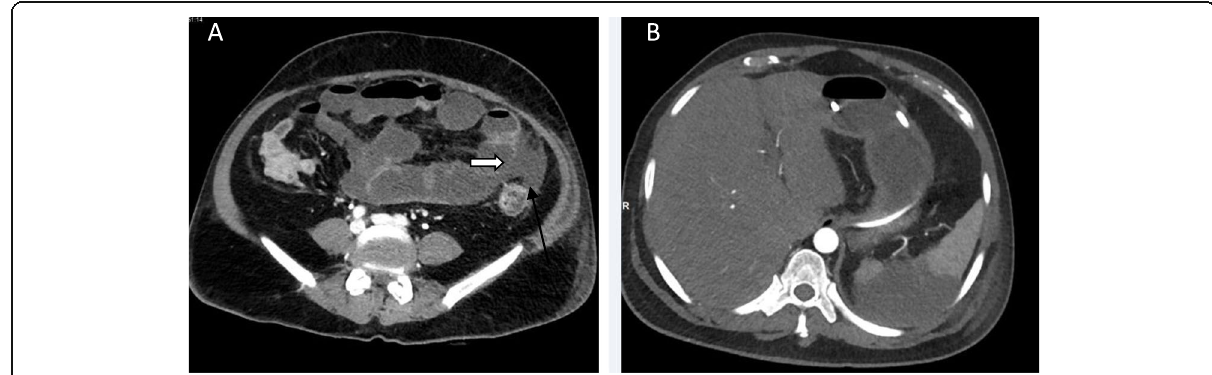
Fig. 1 Fifty-four-year-old COVID-19 male patient admited to the ICU due to respiratory failure presented with abdominal distention. MDCT abdomen was done to exclude bowel obstruction. a Ischemic small bowel changes with focal mural poor enhancement with suspected disruption of the bowel segments (Open arrow) with related mild collection (Black arrow). b Associated sizable splenic infarct in the same patient